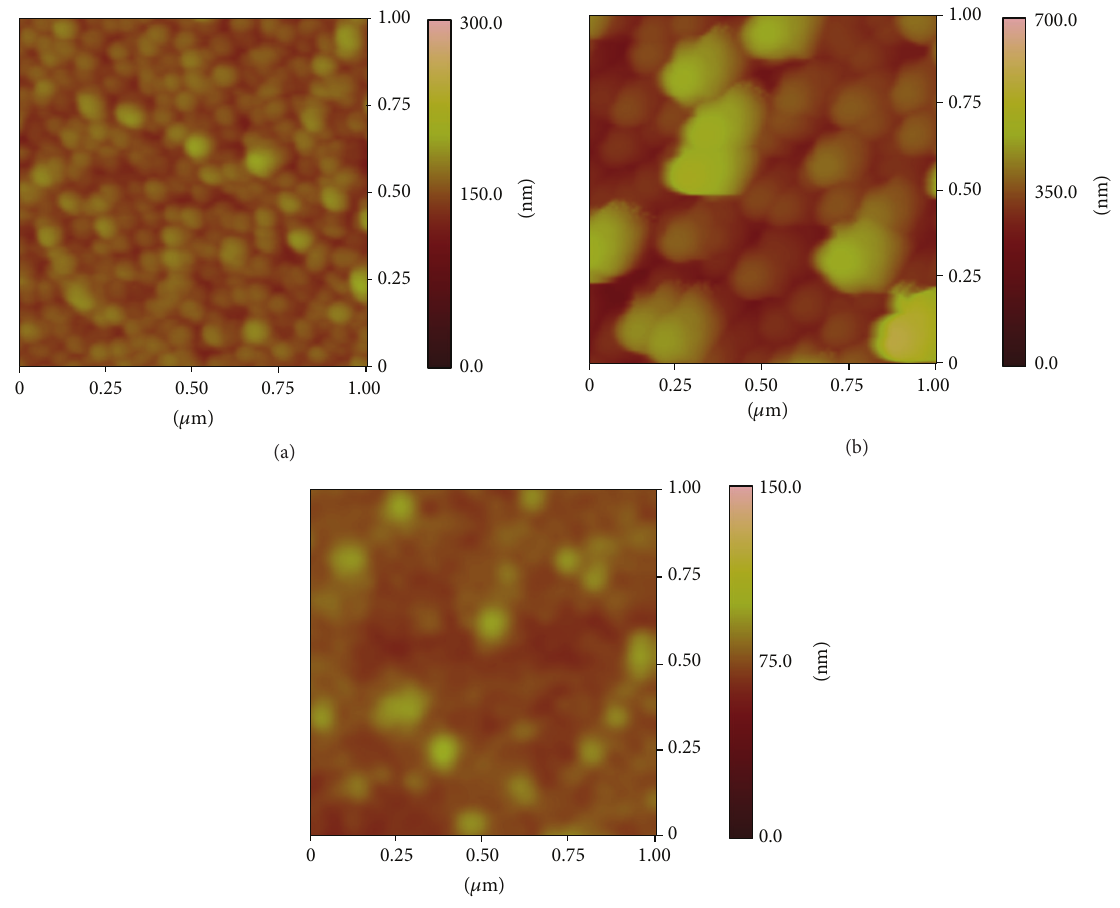
Figure 3: AFM image of (a) C60, (b) CuPc:C60, and (c) P3HT 0.3 :CuPc 0.3 :C60 0.4 thin